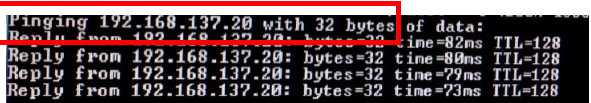
Figure 13. The command prompt in pinging IP